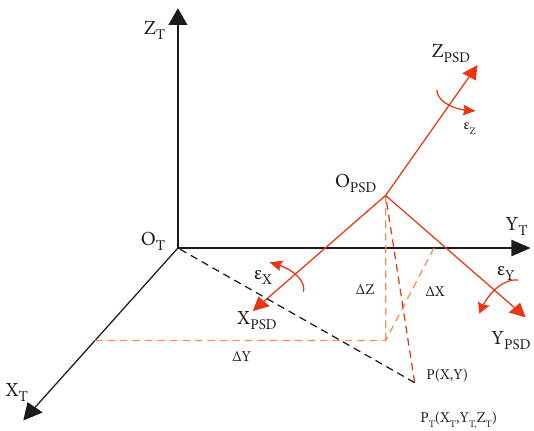
Figure 8: PSD coordinate system, space Euclidean coordinate system, and their